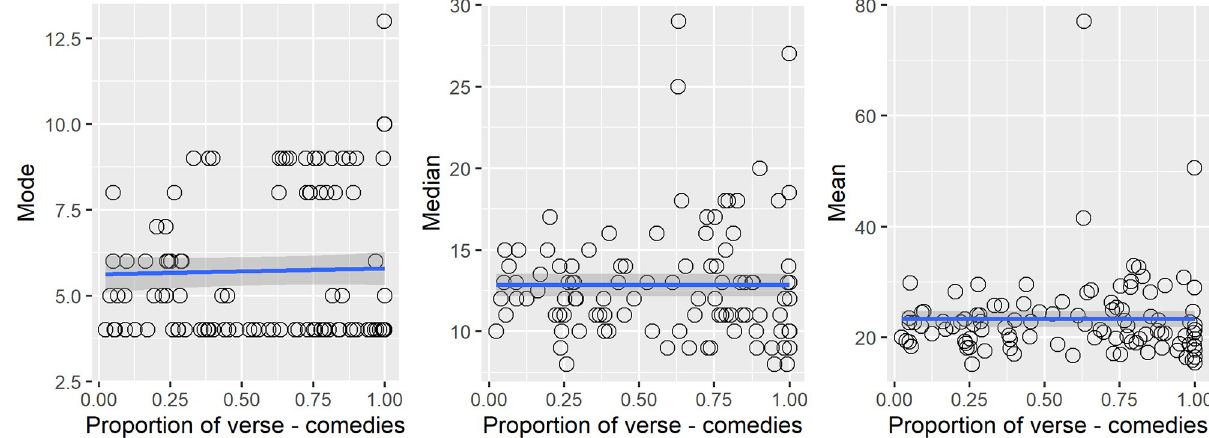
Fig 7. (S1 Fig 8 in S1 File) Comedies only: Mode, median and mean of speech lengths versus proportion of verse. The fitted line is based on a GAM smoother.